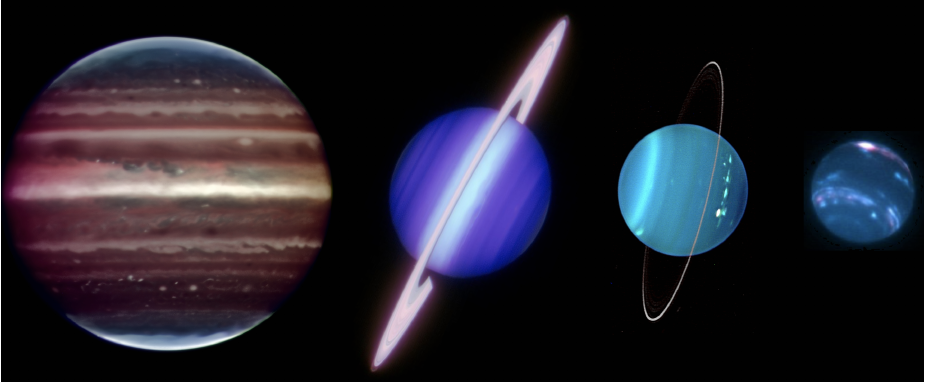
Figure 3. The giant planets’ appearance at near-IR wavelengths with adaptive optics. This Jupiter (VLT, 2008) false-color composite at 2.02 (R), 2.14 (G), and 2.16 (B) microns highlights high polar and equatorial hazes and storms [45]. Saturn (Gemini, 2009) in false color at 2 (B), 2.12 (G), and 2.17 (R) microns shows equatorial structure [74], credit: Gemini Observatory/AURA/Henry Roe, Lowell Observatory/Emily Schaller, Insitute for Astronomy, University of Hawai‘i. A Uranus (Keck, 2004) false-color composite at 1.26 (B), 1.62 (G), and 2.1 (R) microns, highlights both its cloud activity and its rings [29]. A Neptune (Keck, 2007) false-color composite from observations at 1.65 (B) and 2.1 (R) microns highlights elongated small clouds [41], credit: M. van Dam, E. Schaller and W. M. Keck Observatory. Images are not to